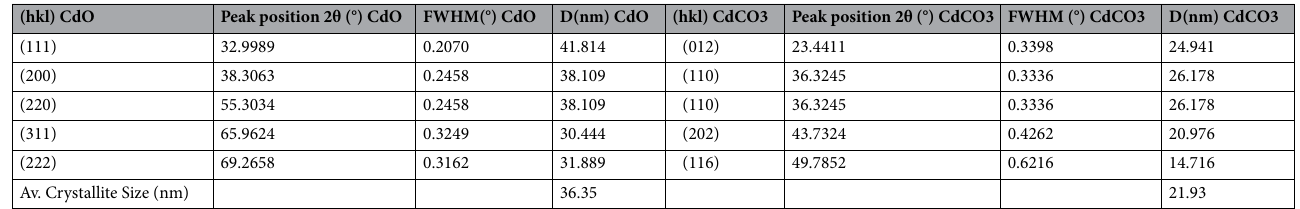
Table 1. XRD showing crystallite sizes derived using reflections from 5 (hkl) planes of CdO.